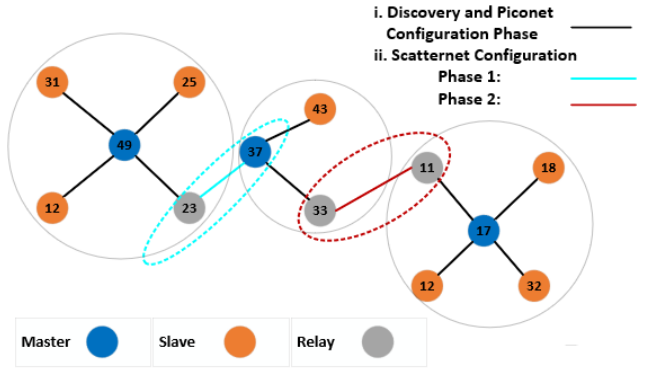
Figure 3. Cluster-based On Demand Routing Protocol